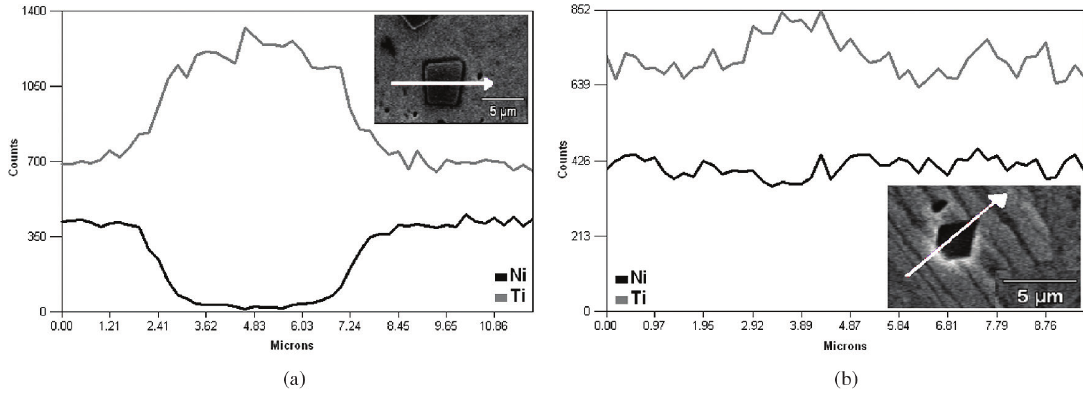
Figure 4. EDS analysis (ND-TD) of the Ti55Ni alloy deformed by 1 ECAE